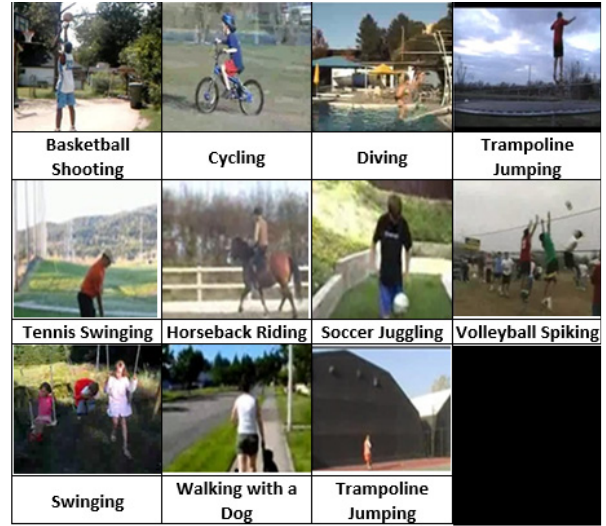
Figure 18. Exemplar frames of 11 sports actions from YouTube action dataset.